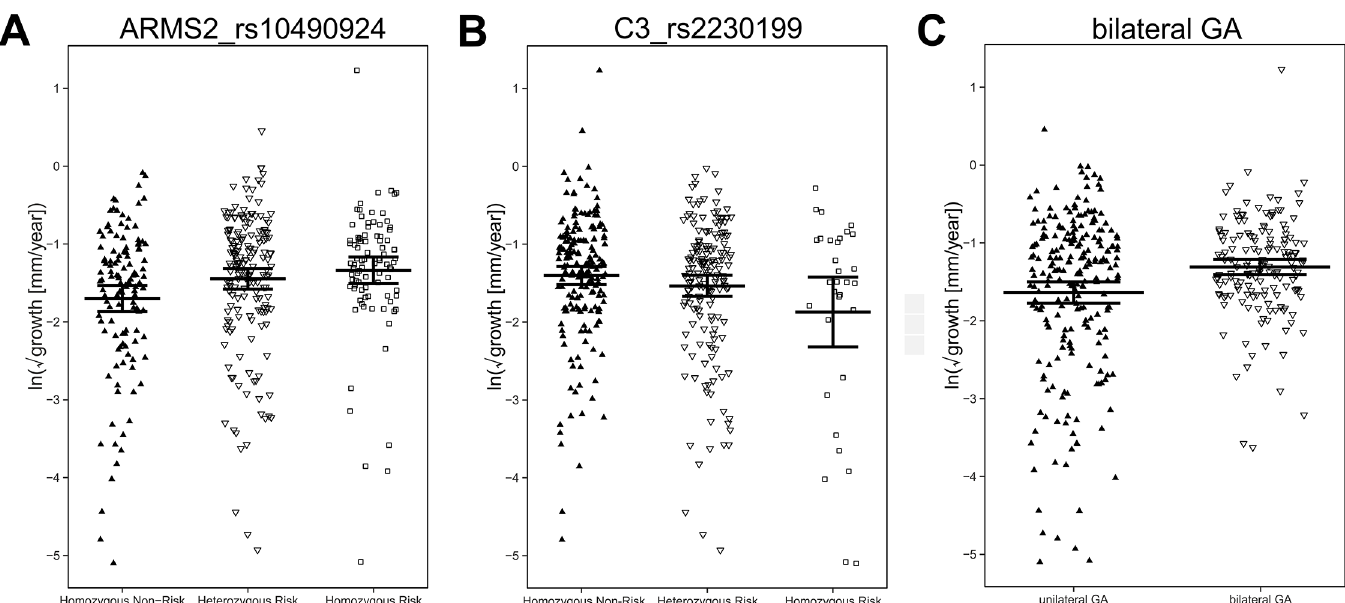
Fig 2. GA lesion growth rates for each individual in the combined study. The measured area of GA was square-root transformed. From the transformed area the growth rate was calculated per year in [mm/year]. Growth rates from each individual were then obtained by calculating the mean of all growth rates of the individual. If both eyes were affected, the mean of both eyes were calculated resulting in a single growth variable per individual. These individual growth rates were further transformed by the natural logarithm (ln) and were stratified either by (A) the genotype at ARMS2_rs10490924 or (B) the genotype at C3_rs2230199 or (C) the presence or absence of bilateral GA.